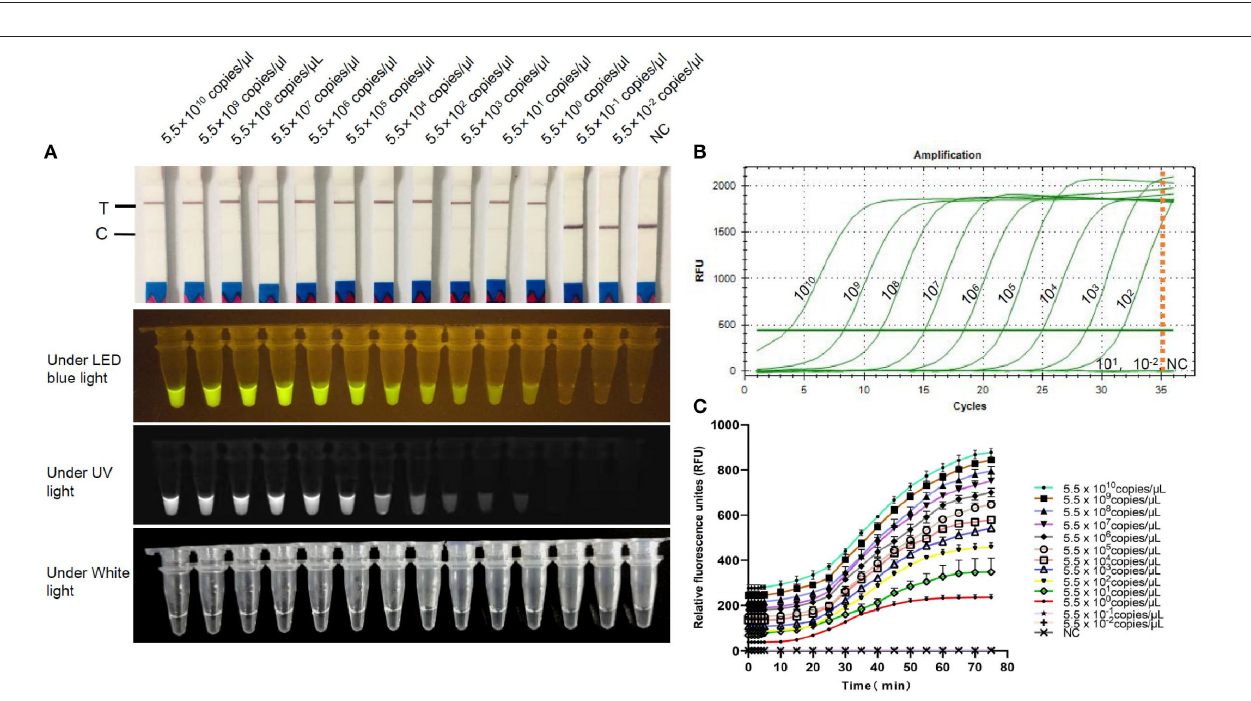
FIGURE 6 | Sensitivity testing of FCV-Cas13a assays. (A) Detection results of FCV-Cas13a-LFD and FCV-Cas13a-FLUOR. Gradiently diluted FCV plasmid DNAs were detected using FCV-Cas13a assays. The minimum detection limit was 5.5 copies/ µ l. (B) RT-qPCR amplification curves. No amplification curve was recorded when the plasmid DNA concentration was lower than 5.5 × 10 2 copies/ µ l. (C) Detection results by FCV-Cas13a-FLUOR were shown in fluorescence profiles. Each experiment was repeated three times. NC, Negative control (RNase-Free distilled water).